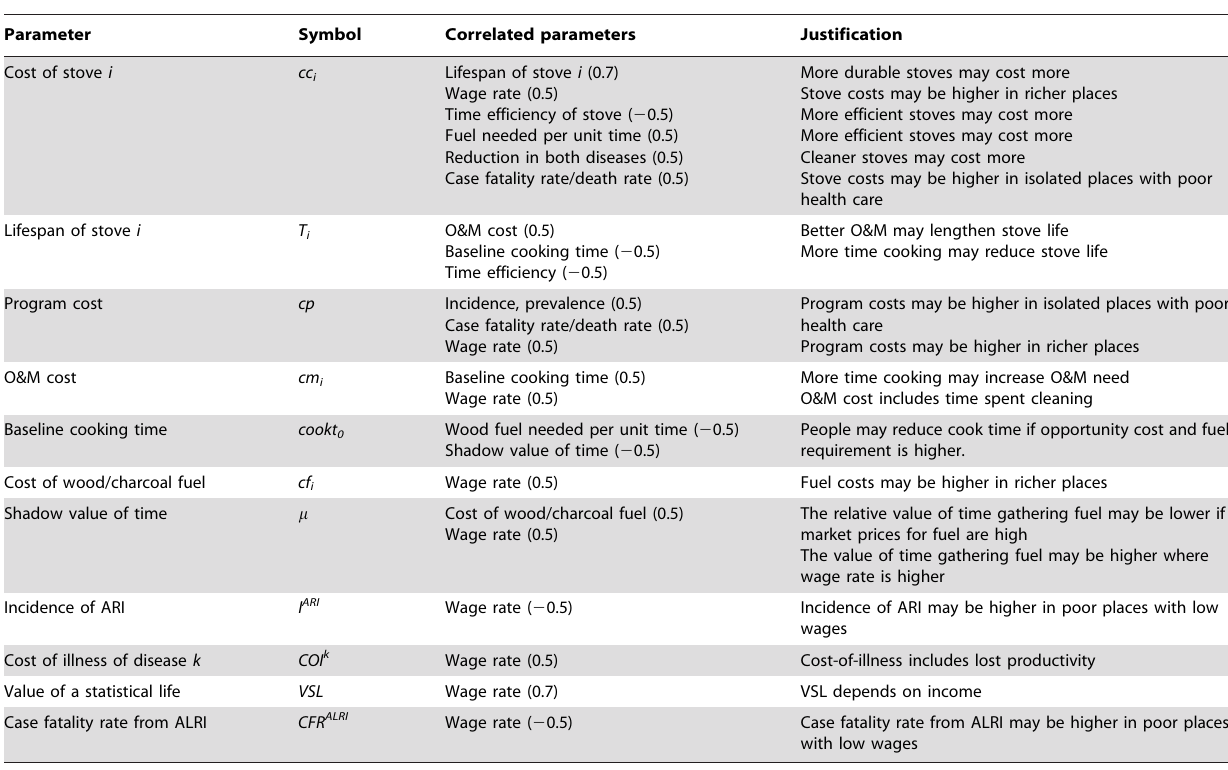
Table 3. Assumed model parameter correlations 1